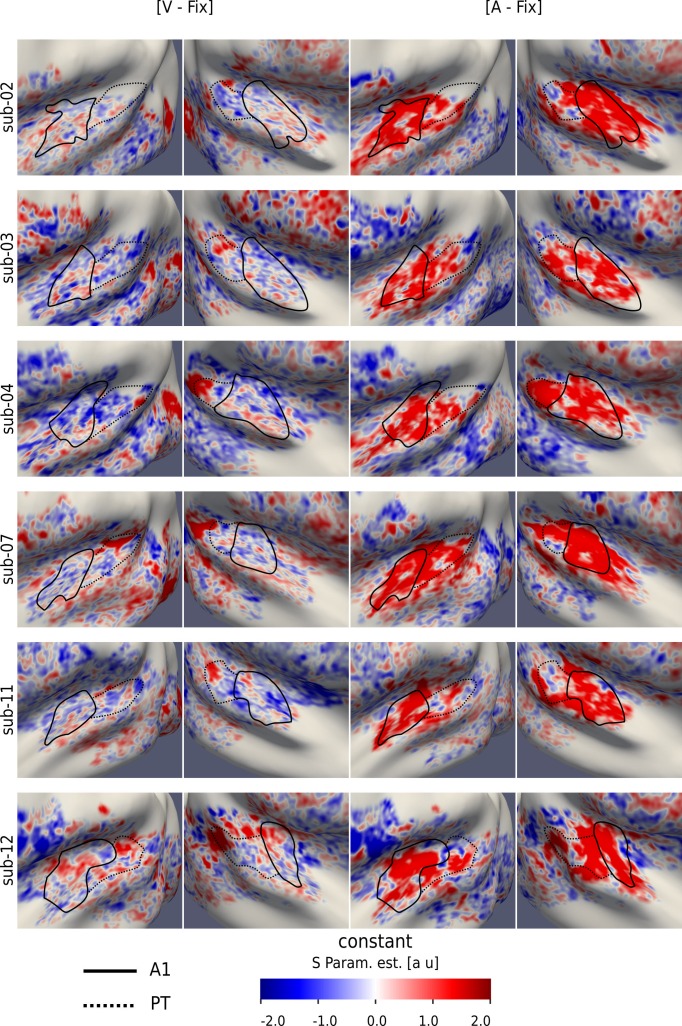
Auditory and visual responses in auditory areas.Surface projection for individual subjects: Within subject ‘constant’ shape parameter estimates of the laminar BOLD response profile for visual (column i and ii) and auditory (column iii and iv) are projected on each subject’s inflated surface to show visual regions of the left (column i and iii) and right (column ii and iv) hemisphere. A1 and PT are delineated by black solid and dashed lines, respectively. For visualization purposes only, surface projections were smoothed (FWHM = 1.5 mm). Grey areas denote vertices with no available data.